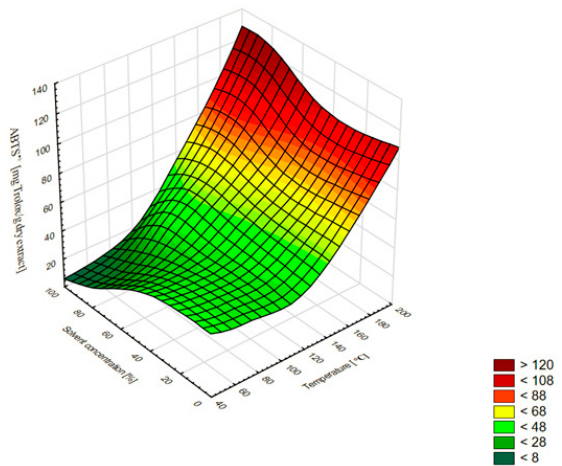
Figure 4. Three-dimensional surface chart of the ABTS •+ vs. temperature and solvent concentrations for all extraction methods (smoothing of the smallest squares weighted by distance).